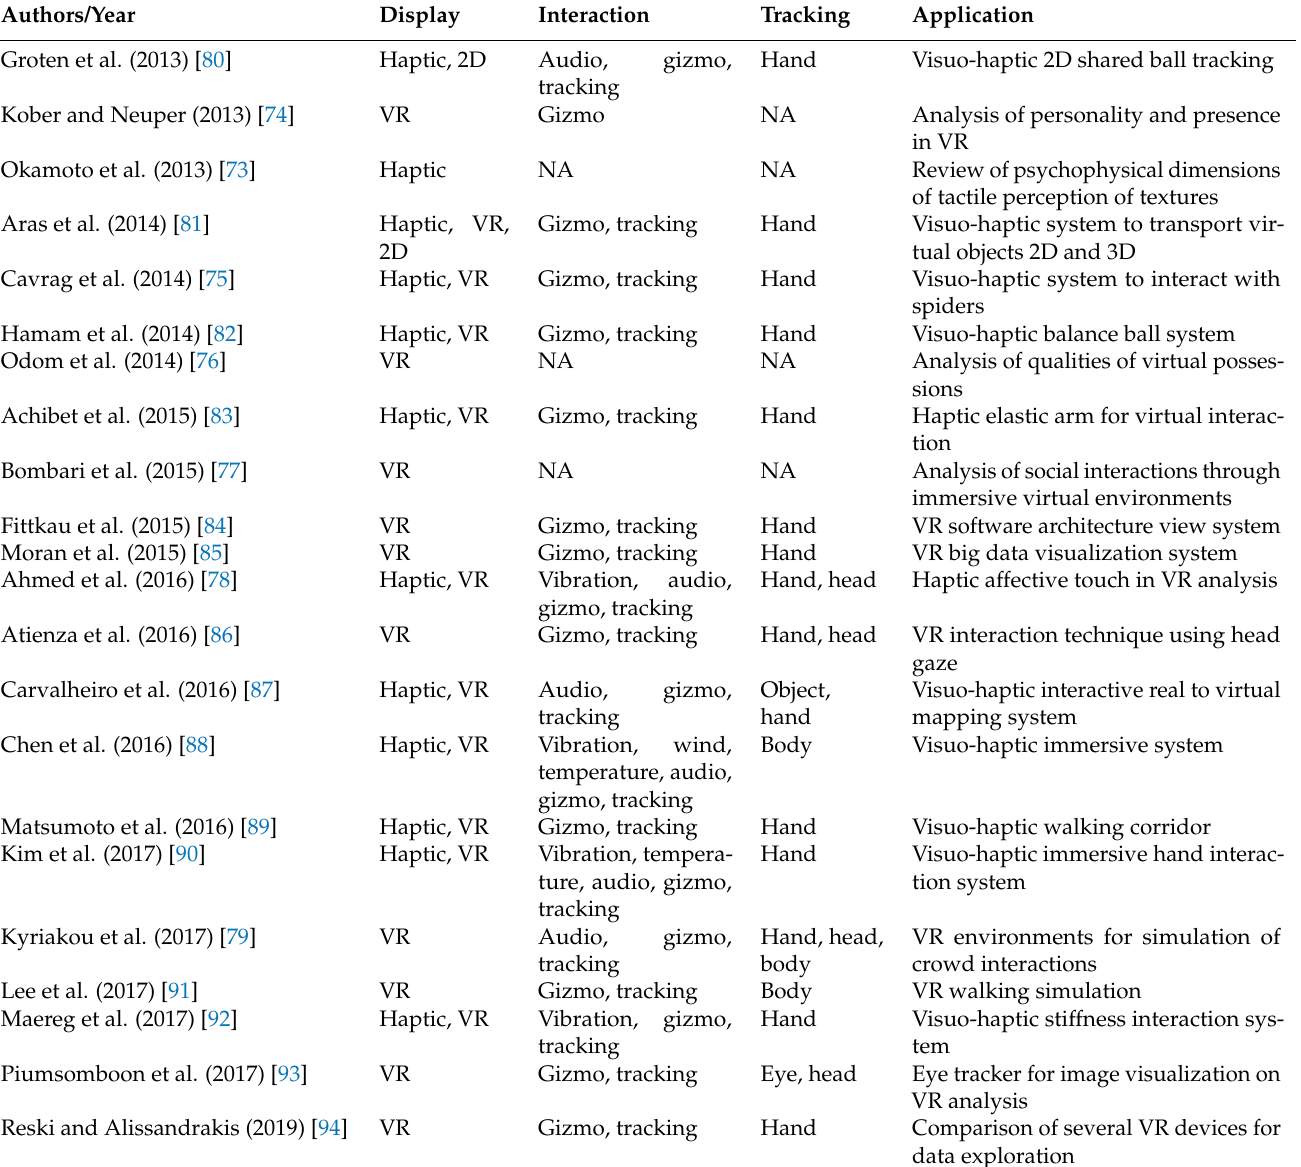
Table 5. Data table of the human factors/user experience design (UX)